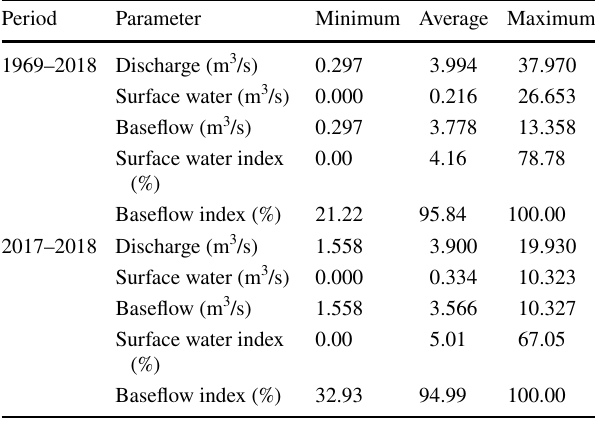
Table 3 Results of the WT for flow separation in different periods Period